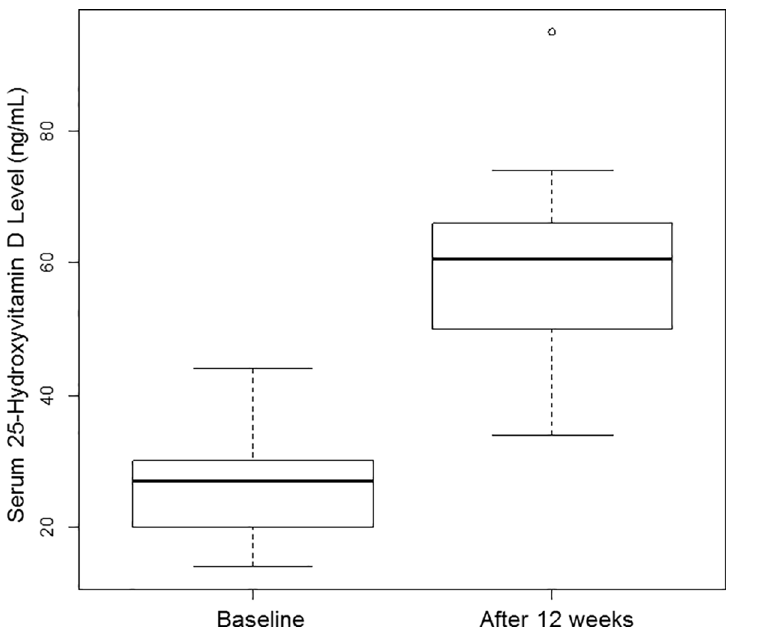
Fig 2. Vitamin D status at baseline and after